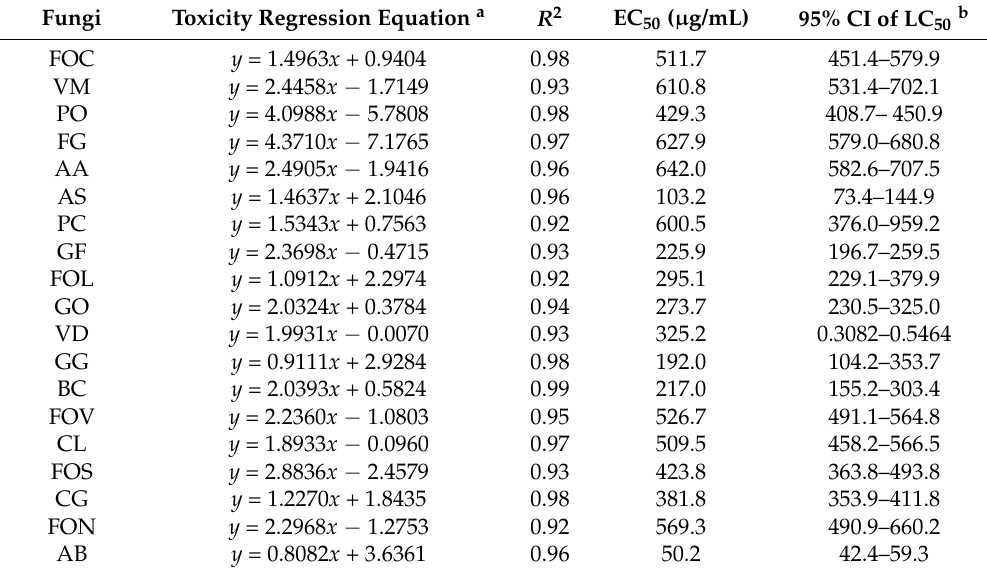
Table 3. Toxicity regression equations for concentration effect and median effective concentration (EC 50 ) values of BAEO against 19 strains of